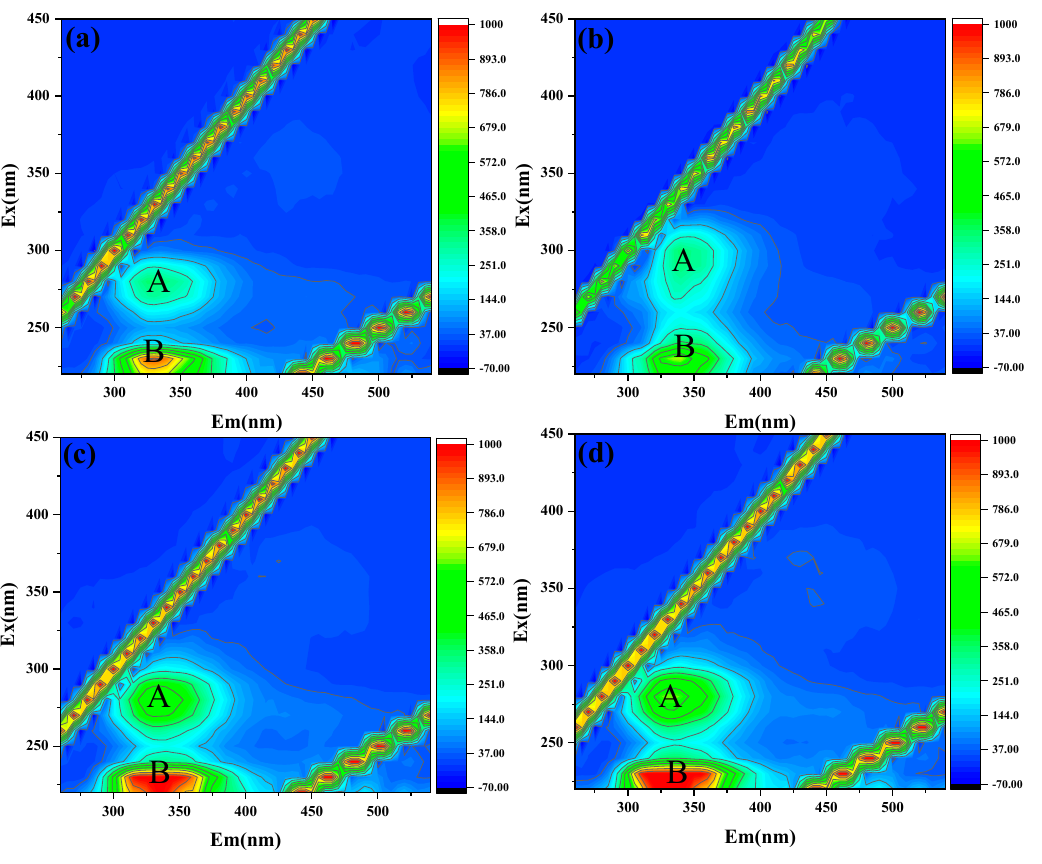
Figure 8. 3D EEM of dissolved foulants extracted from ( a – d ) C5, C7, C13, C20. (peak A and B represent tryptophan-like substance and tyrosine-like substance, respectively). The protein, polysaccharide and TOC contents on the membrane surface were further quantified (Figure 9). Similar to the fluorescence peaks, the contents of protein, polysac- charide and DOC also followed the order of C20 > C13 > C5 > C7. Particularly, the protein content on the membrane surface of C7 was almost zero; the content of polysaccharides was also shown to be extremely low. Both protein and polysaccharide are the main con- stituent of EPS, which have been recognized as a critical factor for membrane fouling in MBR [34,35]. The result indicated that by optimizing membrane pore size, the accumula- tion of EPS on the ceramic membrane could be effectively inhibited, thus alleviating the membrane fouling during MBR operation.